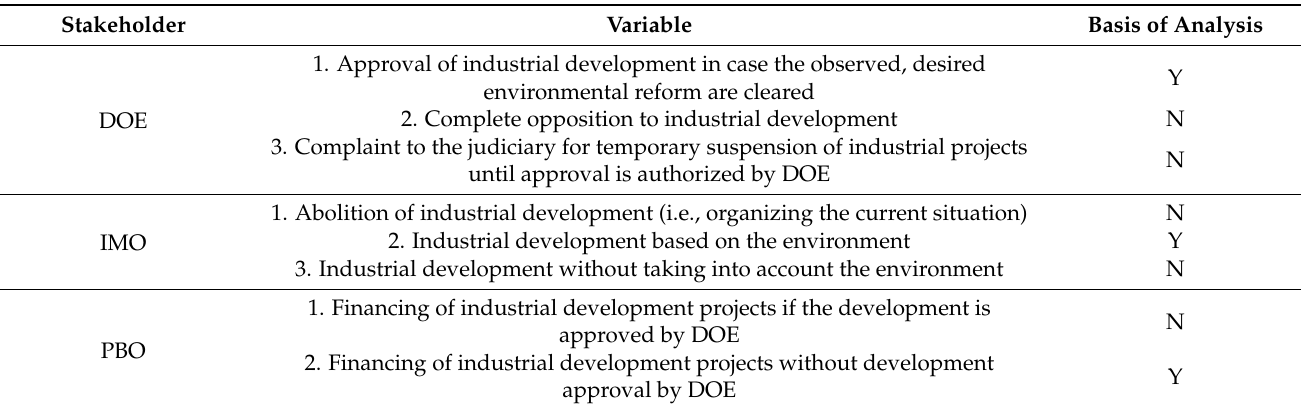
Table 1. Stakeholders, variables, and basis of analysis of Markazi province in the industrial develop- ment conflict.